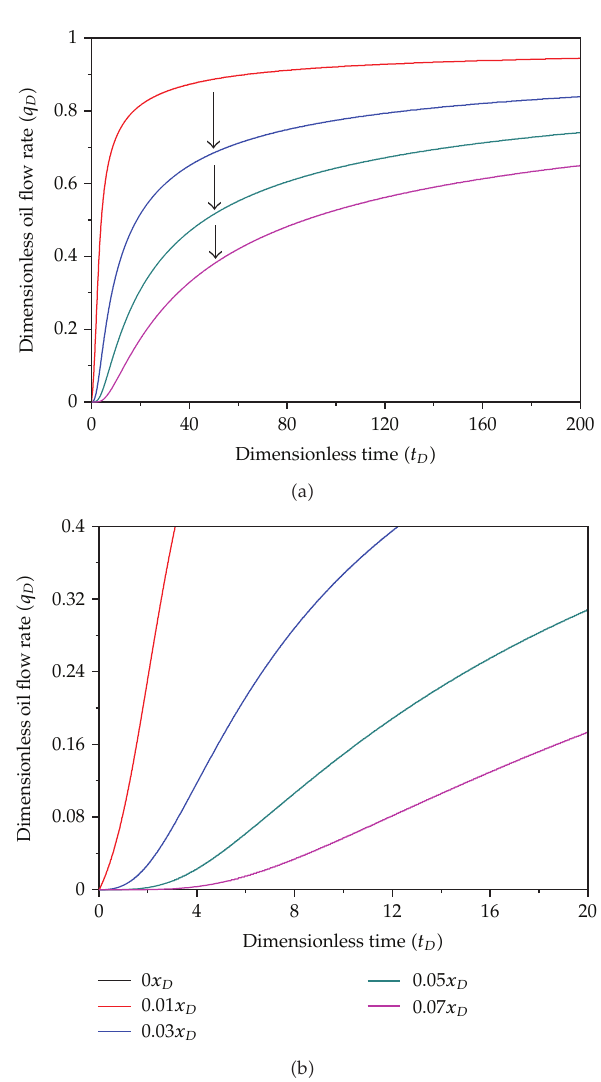
Figure 4: Results from dynamic simulation of the relationship of q D versus t D in di ff erent x D (cid:2) The selected x D is approach to the upper limit temperature (cid:3)